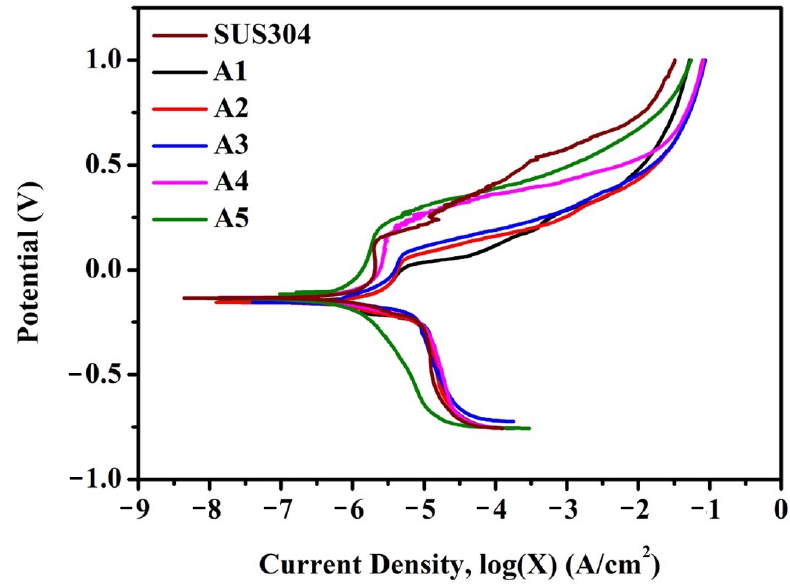
Figure 8. Polarization curves of A1, A2, A3, A4, A5, SUS304, and high-chromium cast iron.